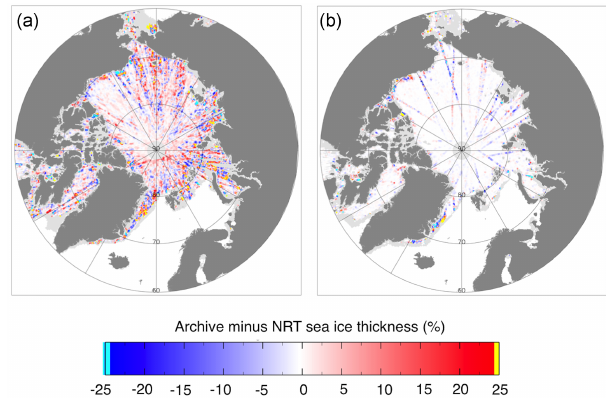
Figure 3. The impact of geophysical corrections on near-real-time (NRT) Arctic sea-ice-thickness estimates from CryoSat-2. (a) Per- centage change in archive minus NRT thickness estimates for the final 28 days of March 2015. In March 2015 the wet-tropospheric, dry-tropospheric and inverse-barometer corrections were missing in 80% of cases. (b) Percentage change in archive minus NRT thick- ness estimates for the final 28 days of April 2015. In April 2015 the wet-tropospheric, dry-tropospheric and inverse-barometer cor- rections were missing in 0% of